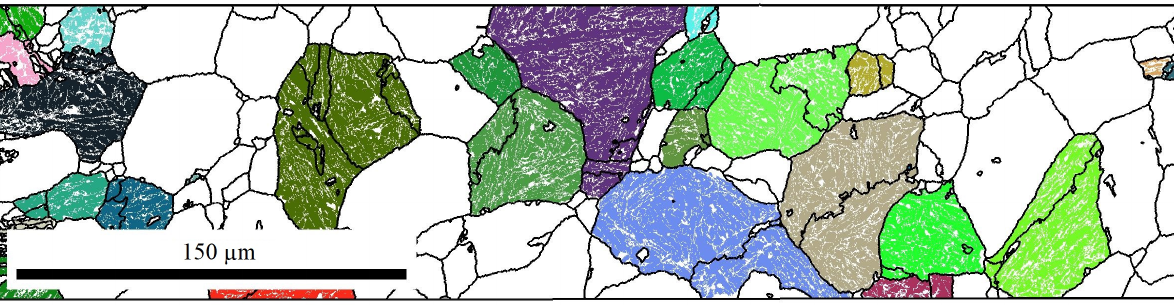
Figure 7. Twins of the reconstructed austenite grains — 0